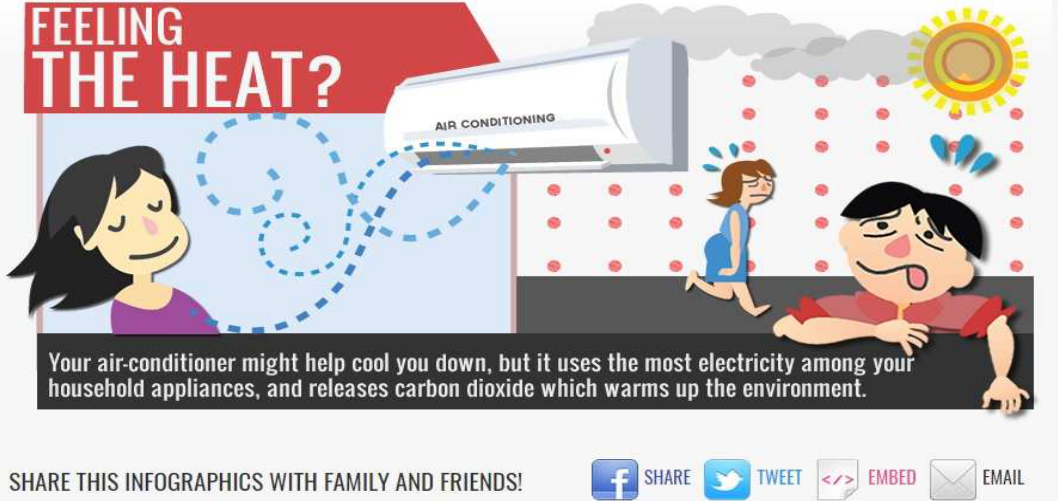
Figure 2. Official website of Singapore Government: Ministry of the Environment and